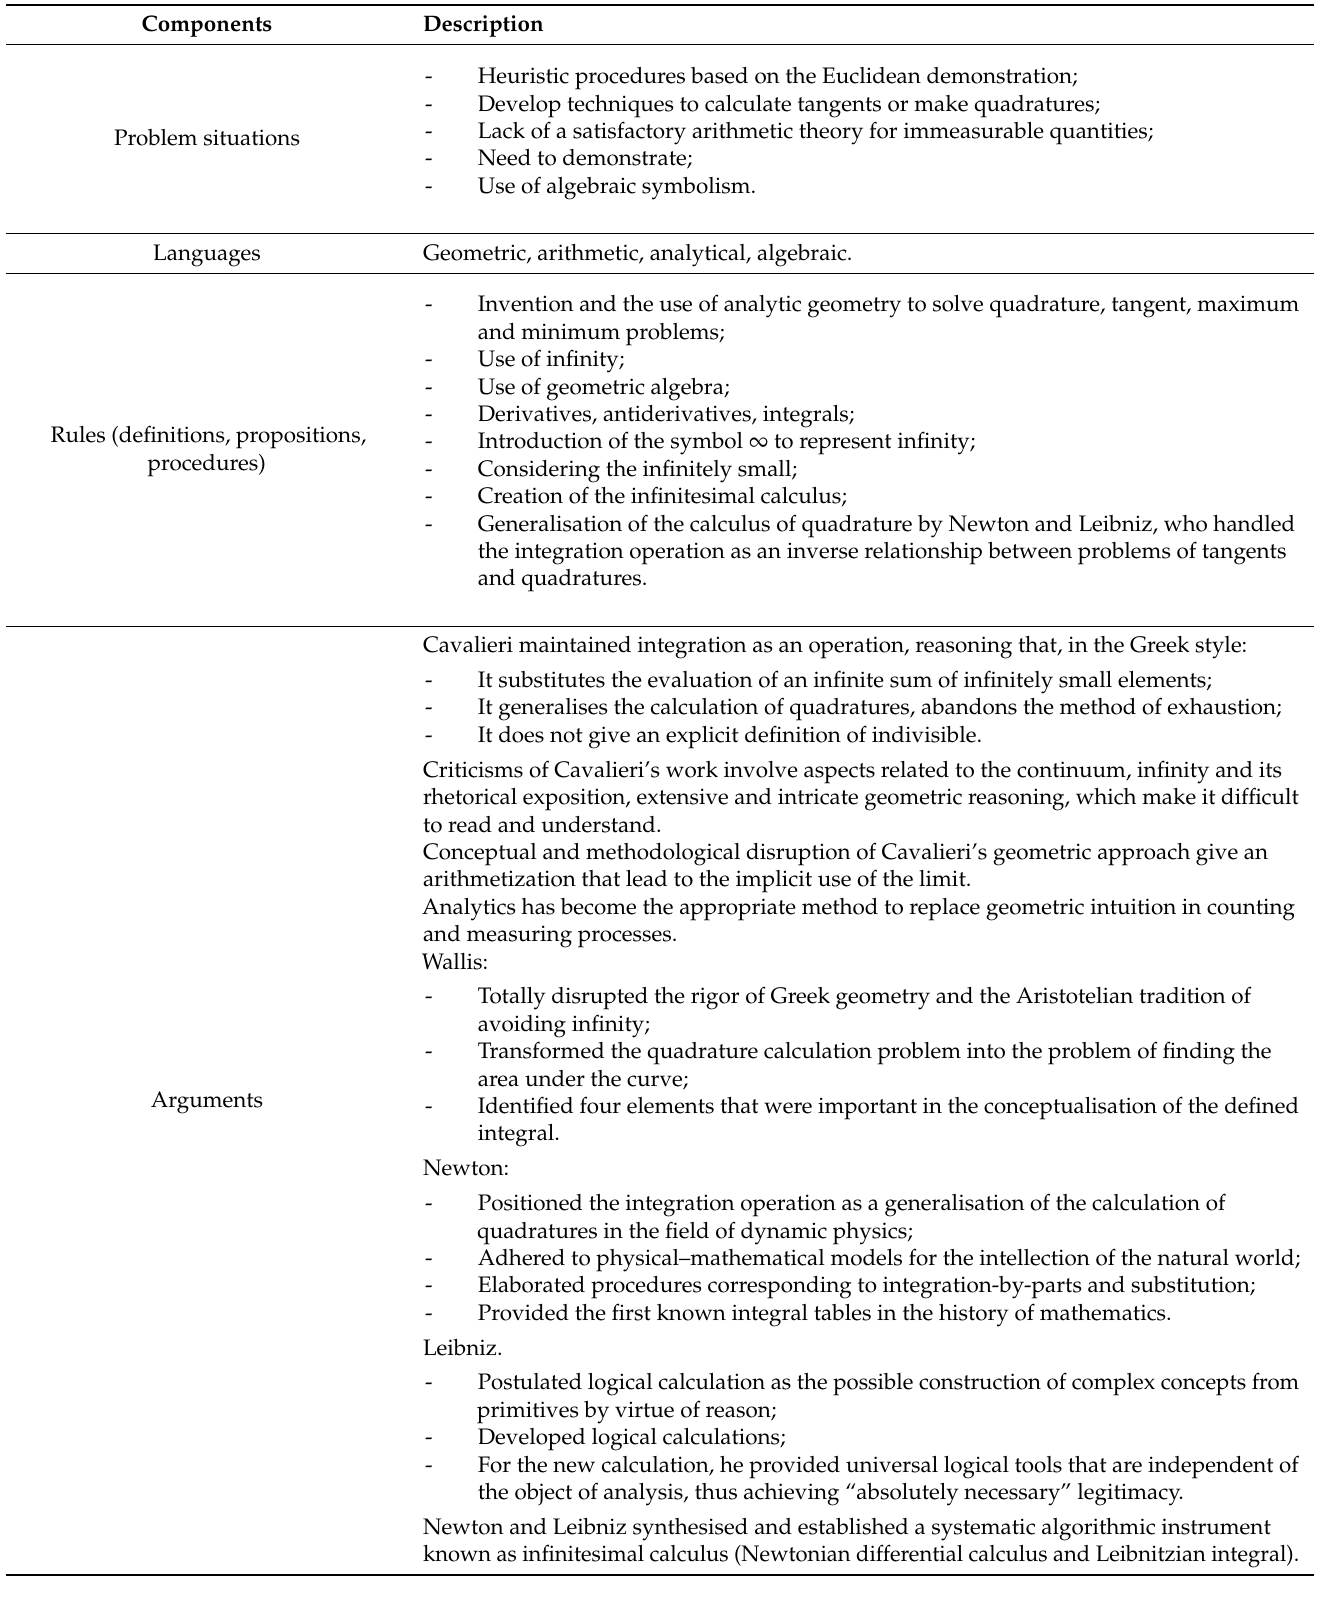
Table 3. GEC2. The integration operation as a support for the nascent Integral